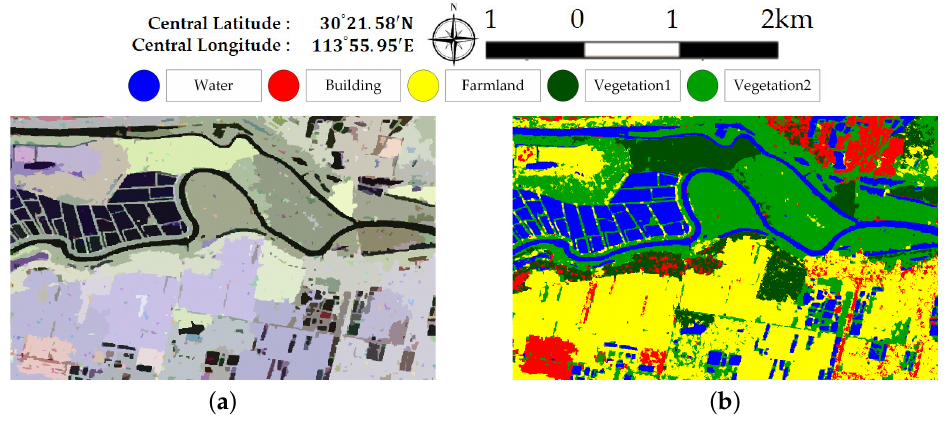
Figure 14. Final classification map of data set B. ( a ) Superpixels generated by SRM. ( b ) Final classification